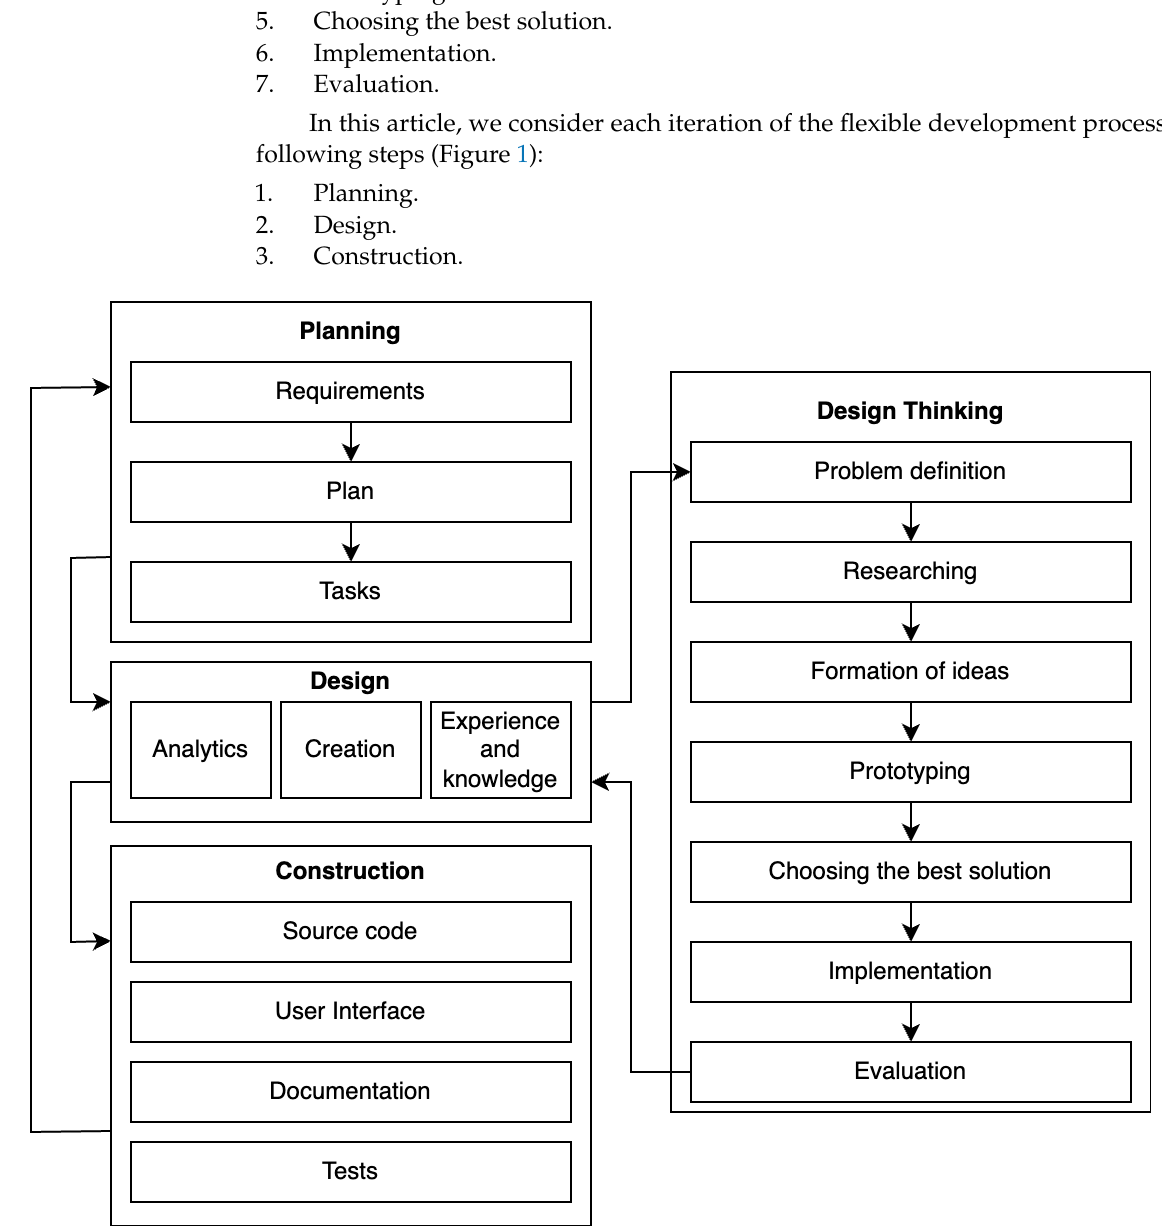
Figure 1. Flexible development iteration